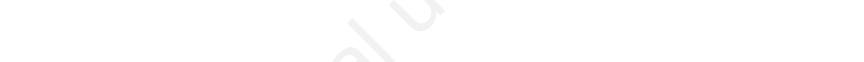
Table 1. Cases of atypical hemolytic uremic syndrome presented with posterior reversible encephalopathy syndrome and renal failure.